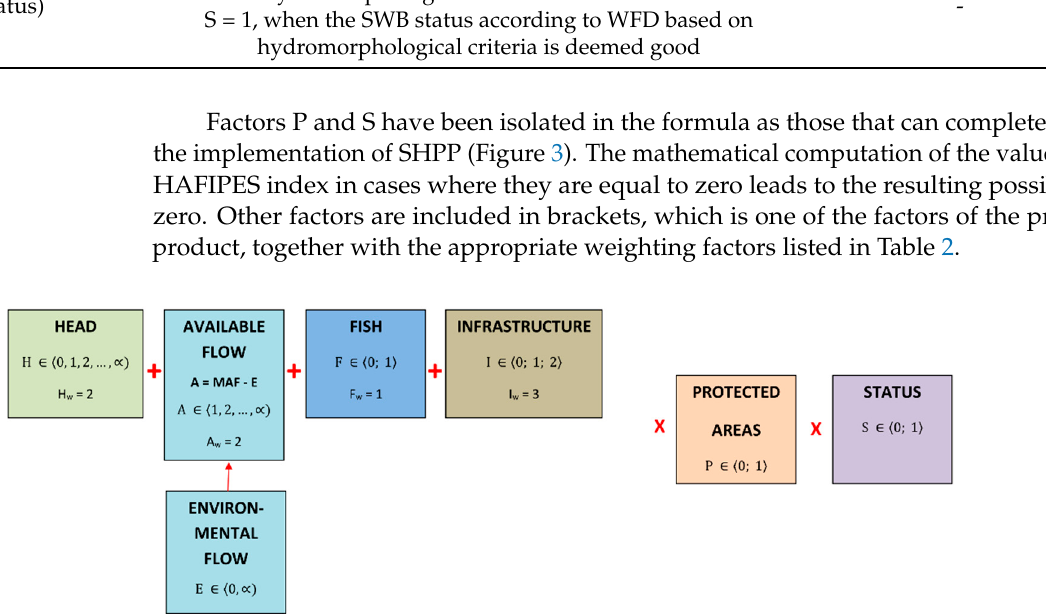
Table 2. Characteristics of factors in the HAFIPES system.